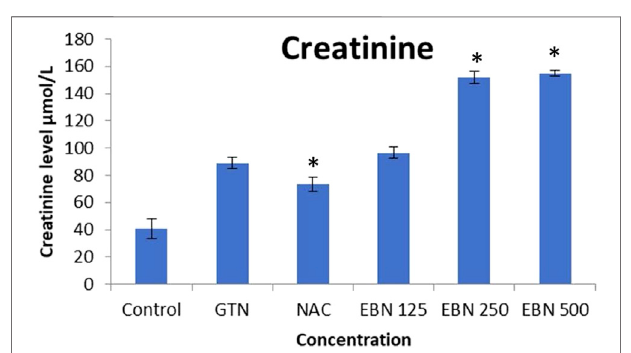
FIGURE 11 | Changes of serum creatinine vs different post-treatment group (* p < 0.05 compare to gentamicin group).